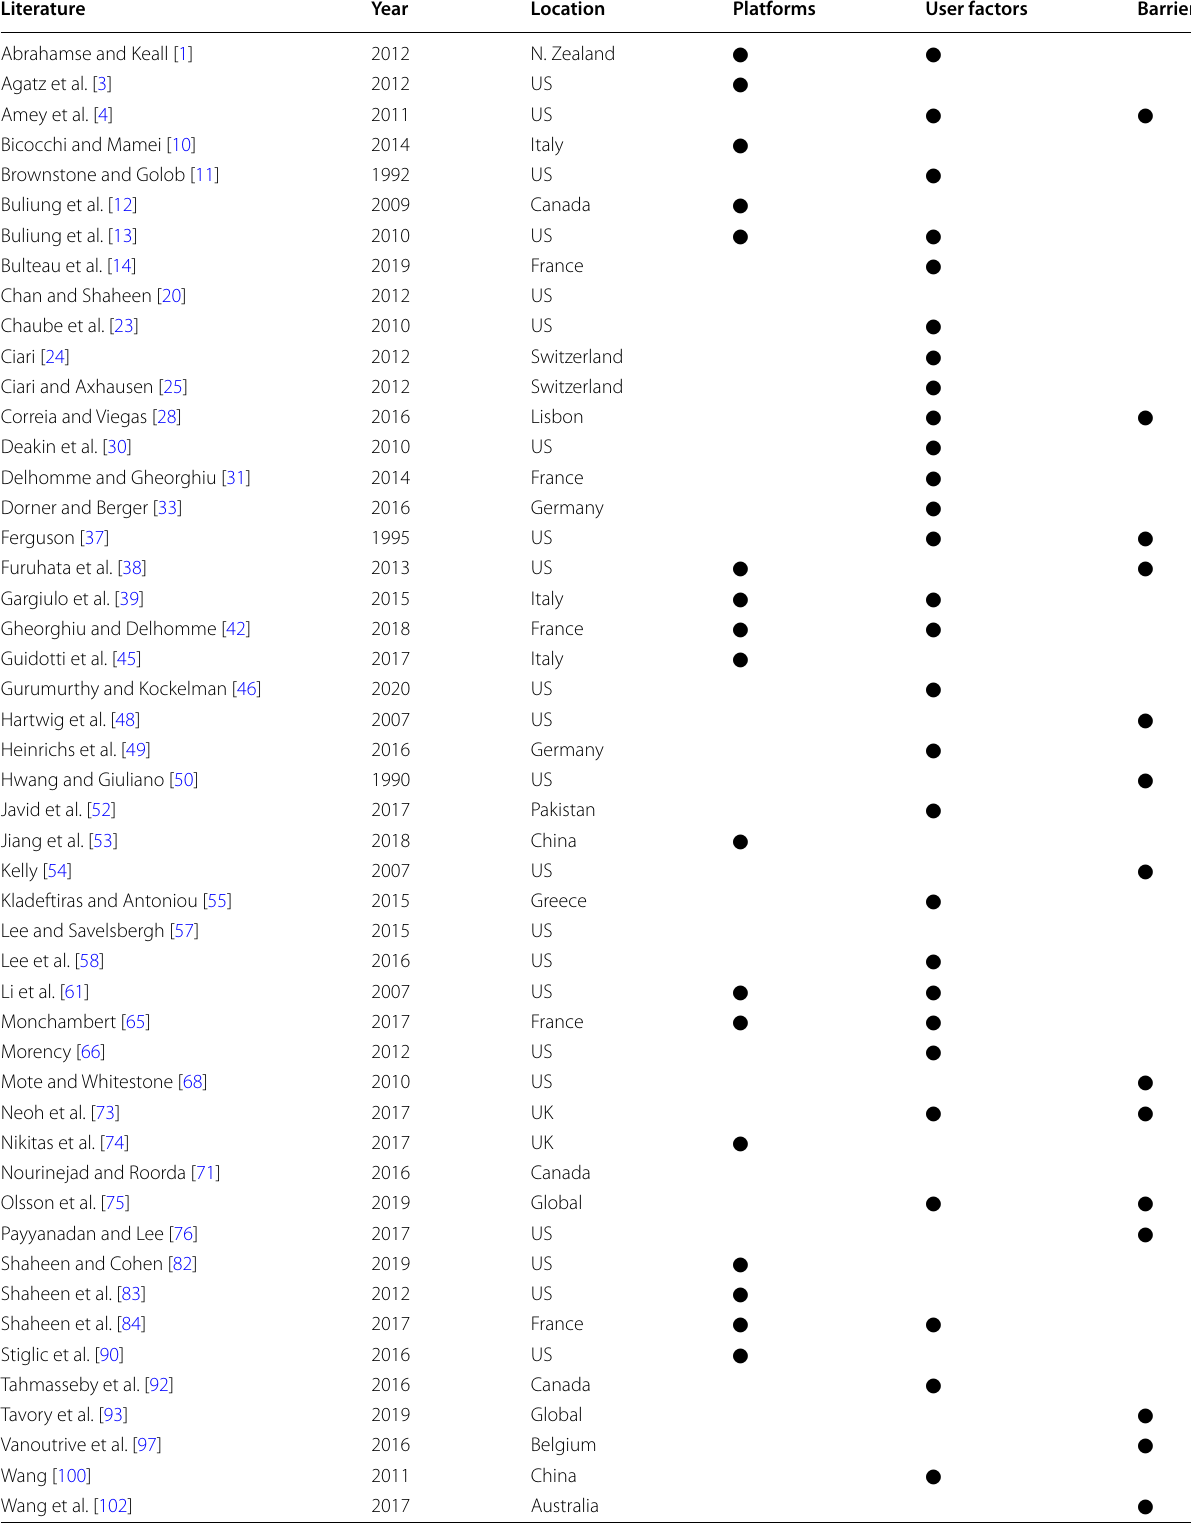
Table 1 Summary of ride-sharing